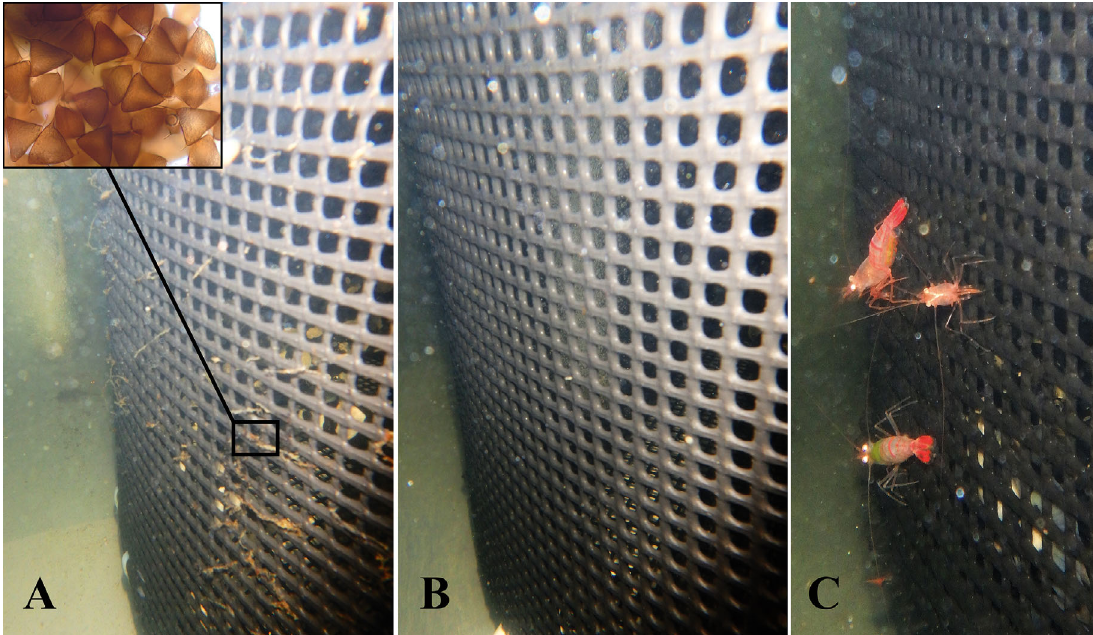
Fig. 3. Underwater photographs of net cages during experimentation; (A) control cage (absence of Lysmata vittata ) with ac - cumulation of Neobenedenia girellae egg masses; (B) treatment cage (presence of L. vittata ); (C) L. vittata feeding on the external surface of a net cage